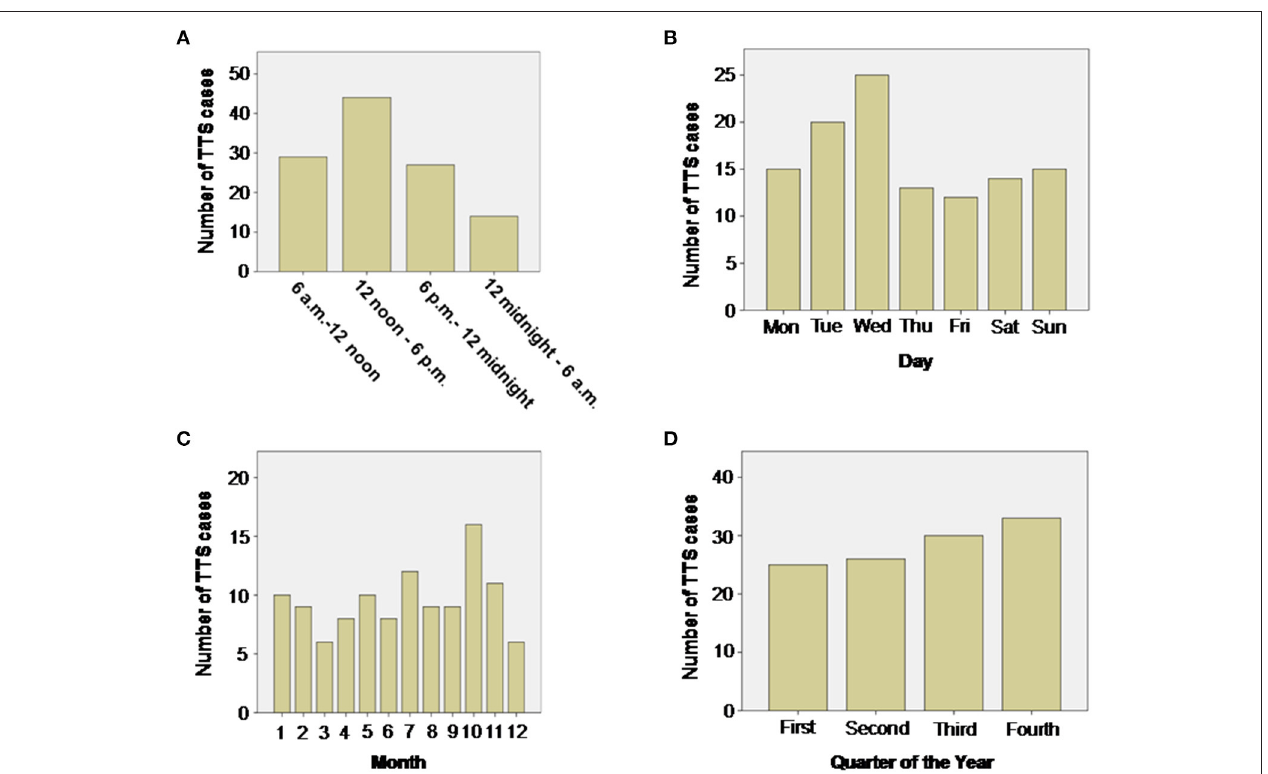
FIGURE 1 | Distribution of TTS events during the day (A) , week (B) , month (C) and quarter of year (D) . During the day the number of TTS events show a wave-like pattern with most TTS events taking place in the afternoon between noon and 6 p.m. ( p = 0.001 Chi-Squared Goodness of Fit Test). No significant differences could be detected by evaluating weeks, months or quarters of year.